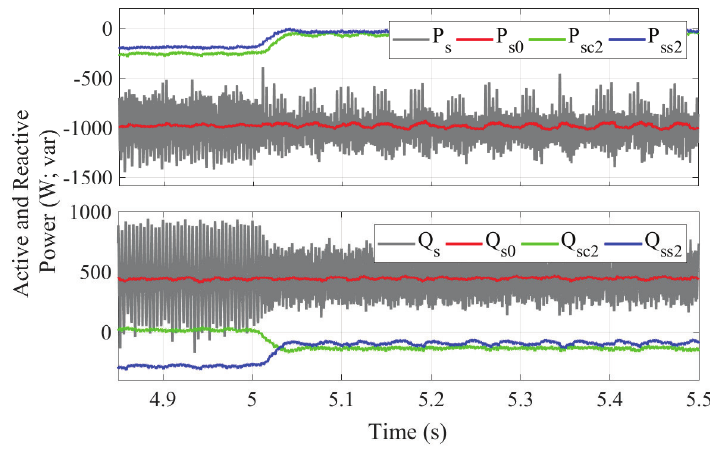
Figure 11. Stator active (W) and reactive (var) power at the beginning of the activation of Objective II for experimental tests.